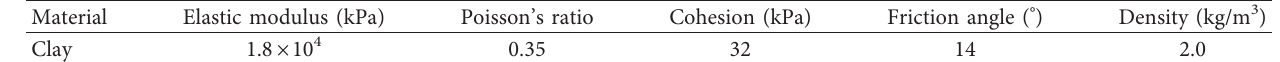
Table 1: Parameters of the materials in model 1.